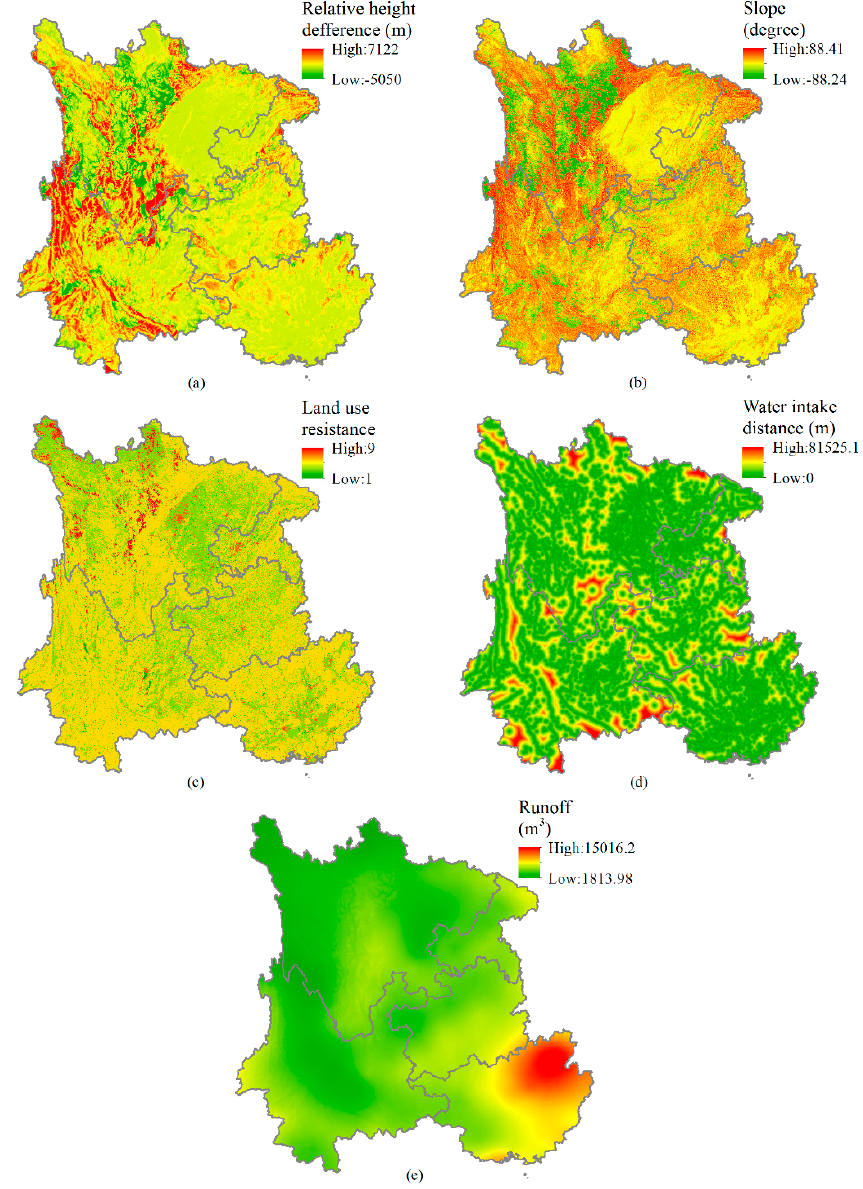
Figure 2. Spatial distribution of different factors affecting water resource accessibility: ( a ) Relative height difference, ( b ) slope, ( c ) land use, ( d ) water intake distance, and ( e ) runoff.